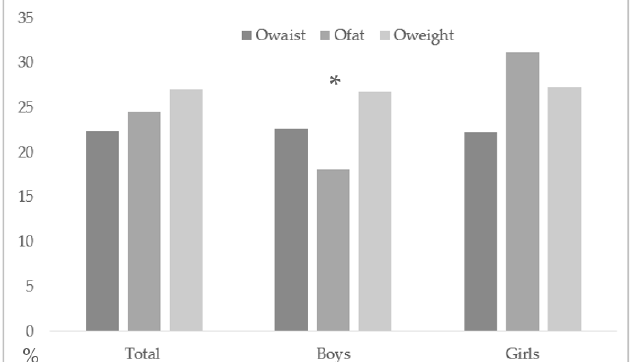
Figure 1. Total percentage of boys and girls (O waist , O fat , and O weight ). * Statistical difference between boys and girls with O fat ( p < 0.05).